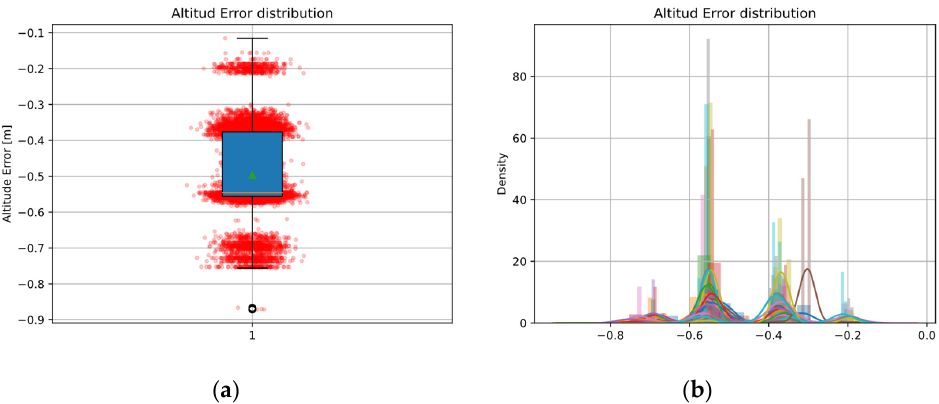
Figure 10. Altitude error: ( a ) Scatter and boxplot. Green triangle: mean, orange line: median; ( b ) Altitude error distribution for twenty different register positions. ( b ) Altitude error distribution for twenty different register positions.